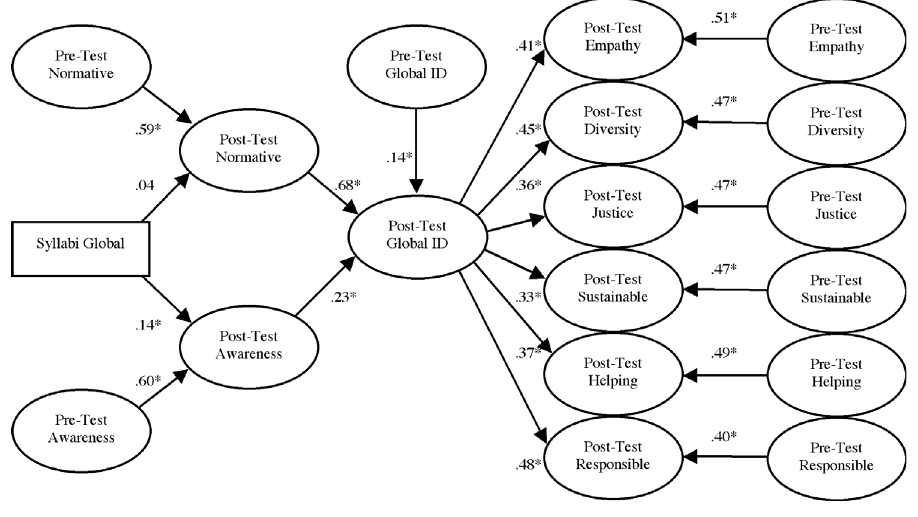
As shown in Figure 1, pre-test latent variables significantly predicted the equivalent post-test latent variables. While controlling for students’ attitudes at the beginning of the semester, the global citizen word count predicted greater global awareness ( β = .14, p < .001, CI = .069 to .199), but did not significantly predict students’ norma- tive environment at the end of the semester ( β = .04, p = .181, CI = -.019 to .106). Post- test ratings of normative environment ( β = .68, p < .001, CI = .605 to .742) and global Figure 1. Influence of a college course with global-infused curriculum (i.e., higher number of global citizen-related words in class syllabi) on antecedents, identification, and outcomes of global citizenship at the end of the semester (controlling for students’ attitudes at the beginning of the semester and measurement error). * p <